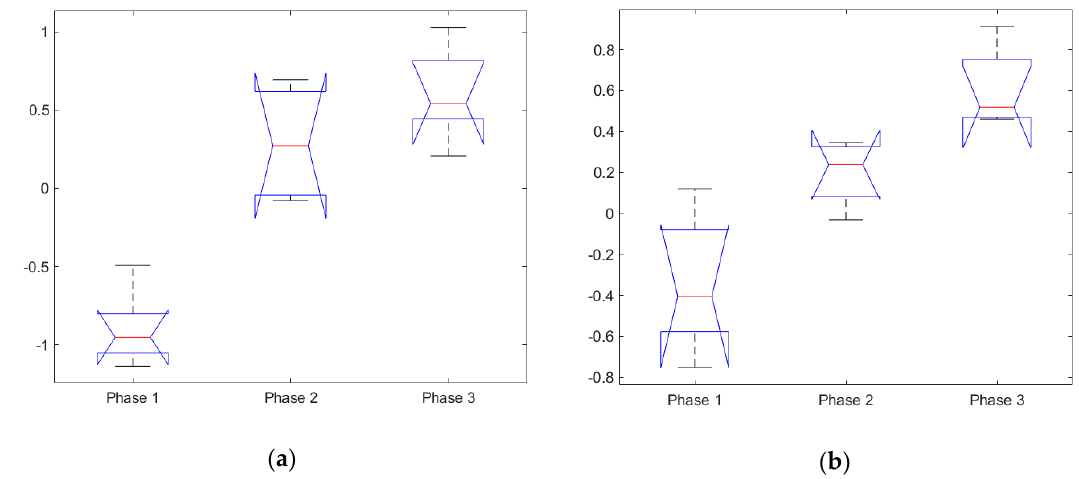
Figure 6. Physiological measures: ( a ) mean visual entropy of all participants (normalized), grouped by the scenario phase and ( b ) mean Electroencephalogram (EEG) index of all participants (normalized), grouped by the scenario phase.